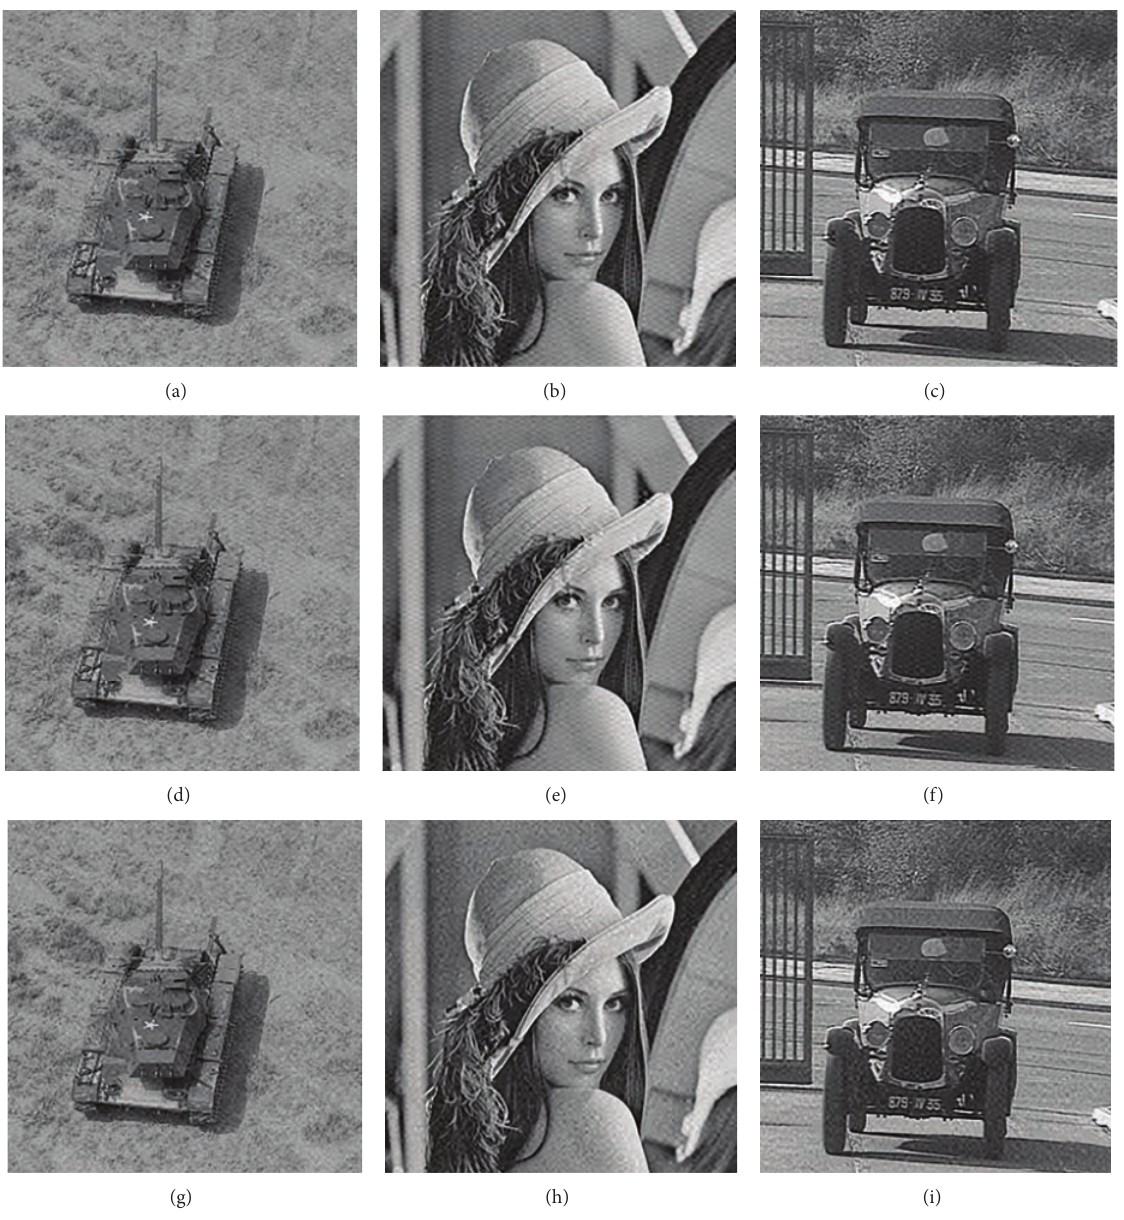
Figure 6: Illustration of the images watermarked by the PriHIW, PostHIW, and TIW. (a) Tank (PSNR = 35.39 dB, 𝐷 Pri = 20.88). (c) Voit (PSNR = 33.11 dB, 𝐷 Pri = 21.81). (d) Tank (PSNR = 34.98 dB, 𝐷 Post (PSNR = 33.35 dB, 𝐷 Pri DWT DWT 33.60 dB, 𝐷 Post = 20.90). (f) Voit (PSNR = 33.42 dB, 𝐷 Post = 21.83). (g) Tank (PSNR = 35.60 dB, 𝐷 TIW DWT DWT 𝐷 TIW = 20.90). (i) Voit (PSNR = 34.31 dB, 𝐷 TIW = DWT DWT